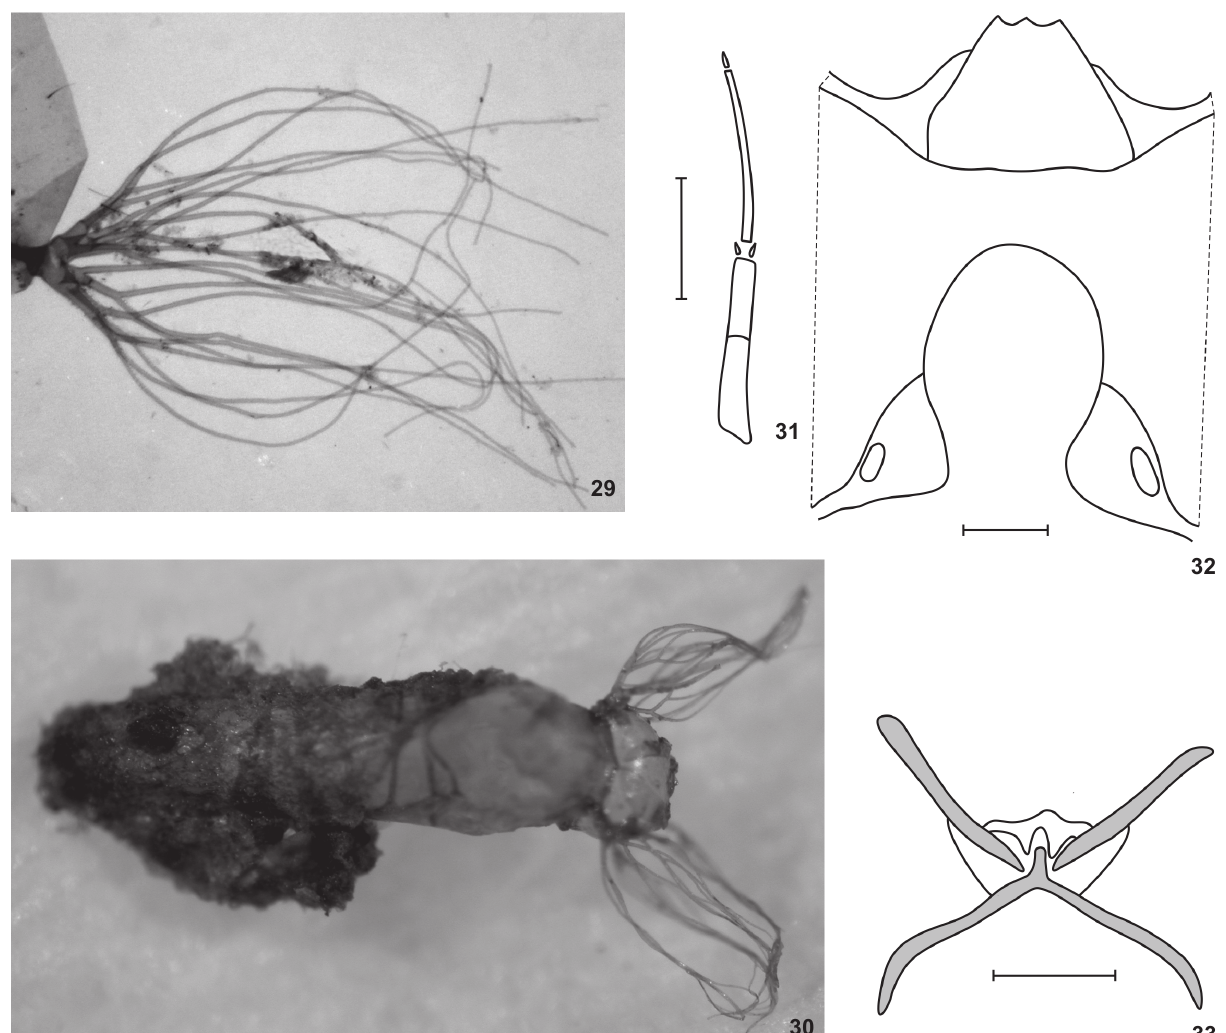
Figure 29-33. Immatures of L. hirticosta : (29-30 pupa) (29) gill; (30) pupa and cocoon. (31-33 larva) (31) antenna; (32) head capsule, ventral view; (33) anal sclerite. Bar: 0.1